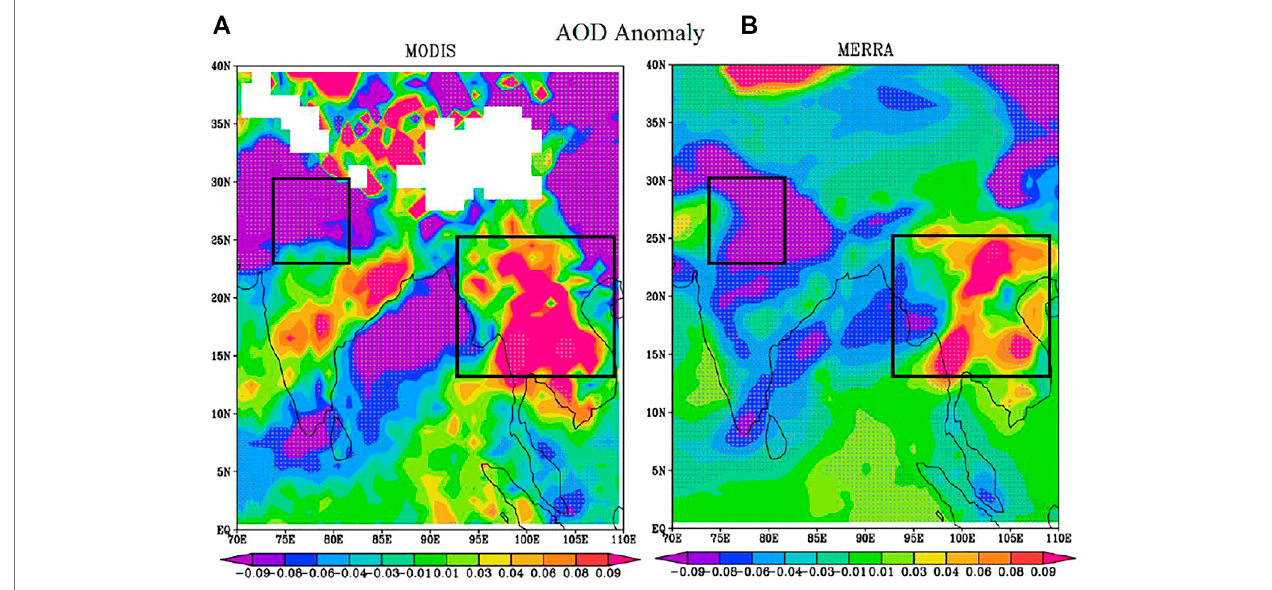
FIGURE 1 | Spatial distribution of anomaly (2020-climatology) in aerosol optical depth (AOD) averaged for the lockdown period from (A) MODIS and (B) MERRA. The white dots plotted on Figures (A,B) indicate a 99% signi fi cance level. Boxes in (A) and (B) indicate North India and Myanmar regions.